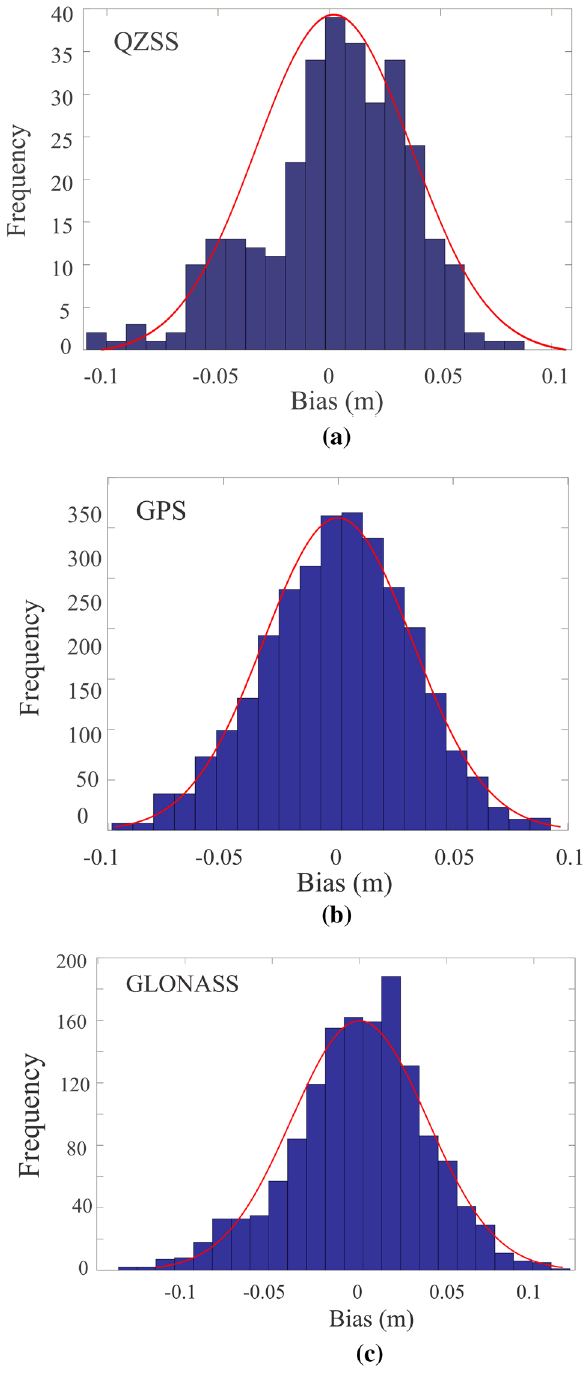
Figure 8. The error histograms between the satellite systems ( a ) QZSS-R, ( b ) GPS-R and ( c ) GLONASS-R and KELM reconstructed Tide gauge